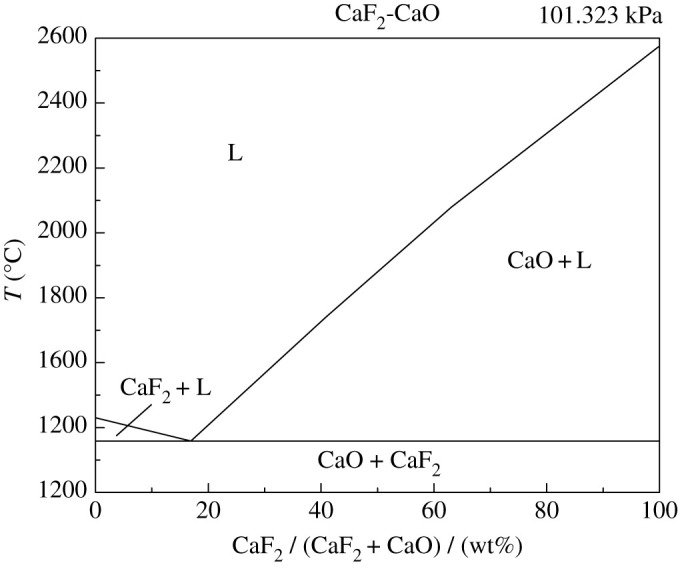
CaF2-CaO phase diagram.